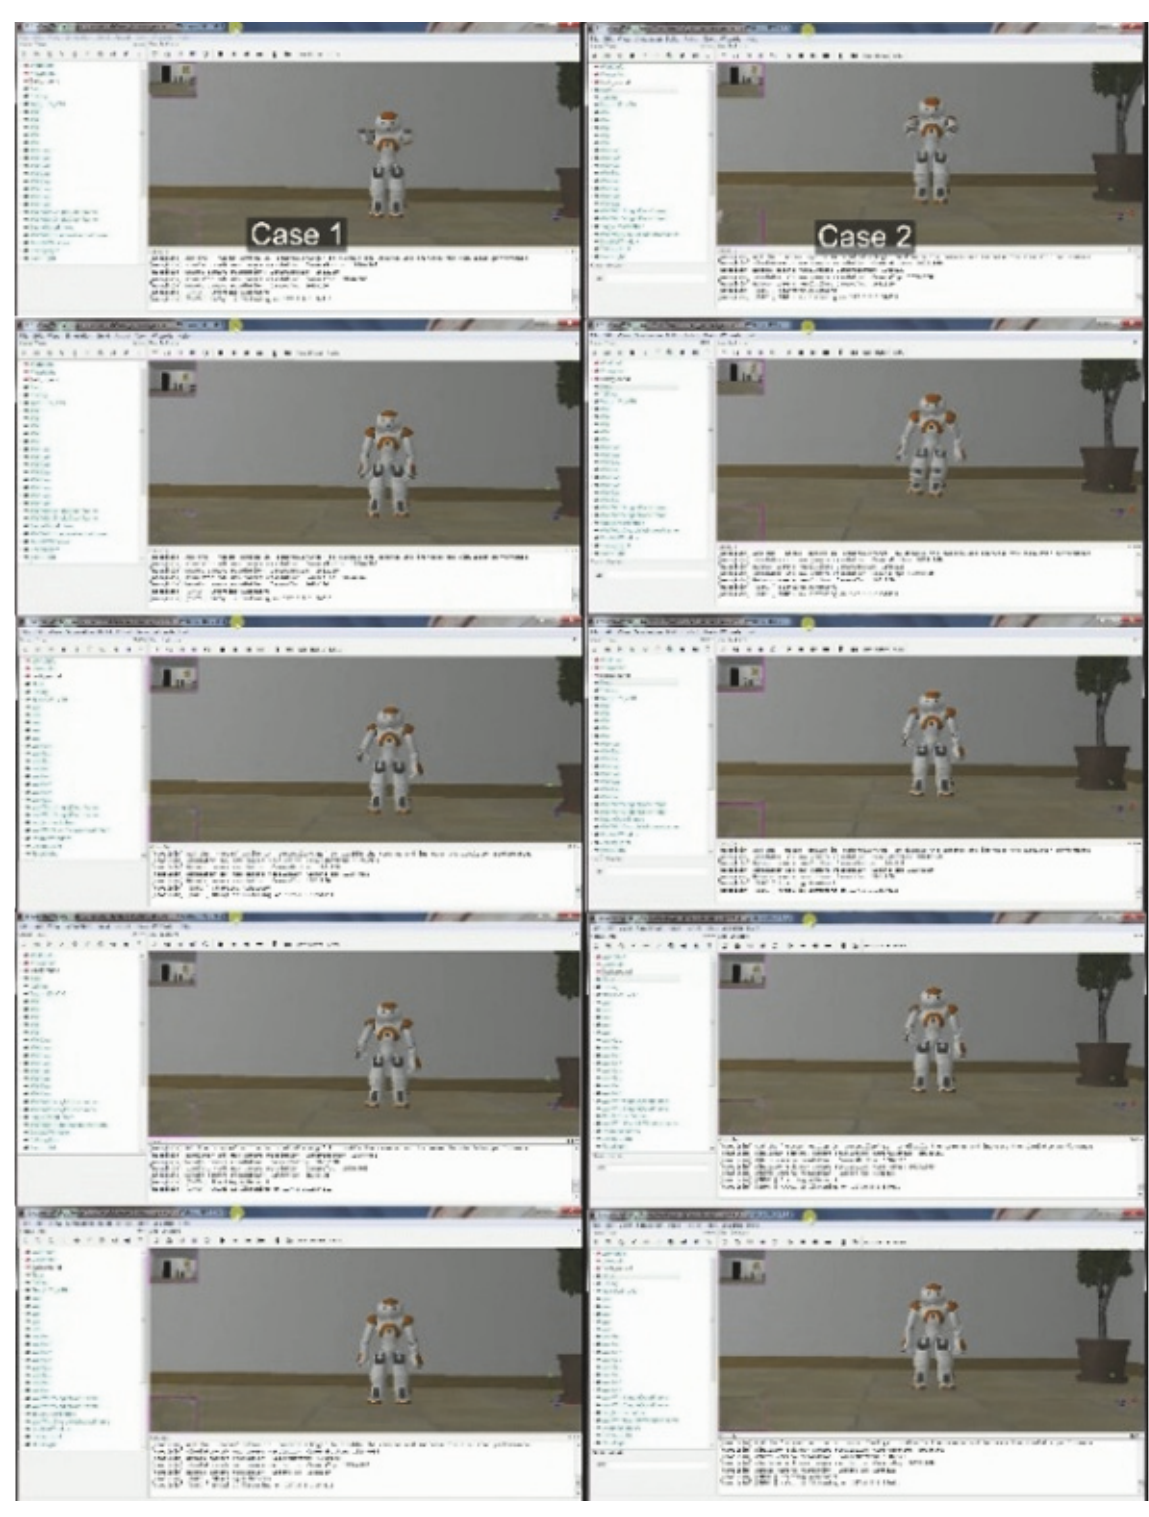
Figure 8: Grabbed frames of shaking hands learning in offline